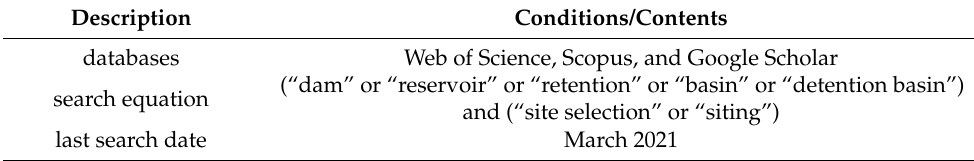
Table 1. Key elements in data